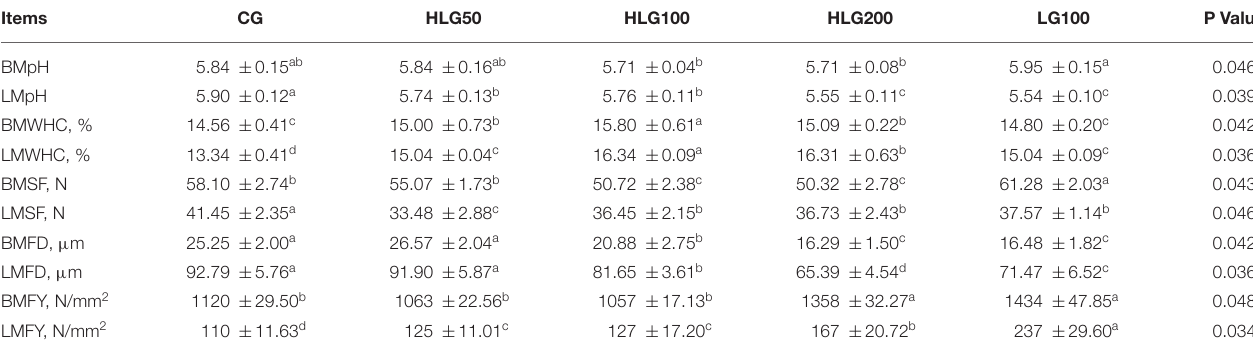
TABLE 9 | Effects of hydroxylated lecithin on meat muscle water holding capacity and shear force of Jiangnan White goslings. Items